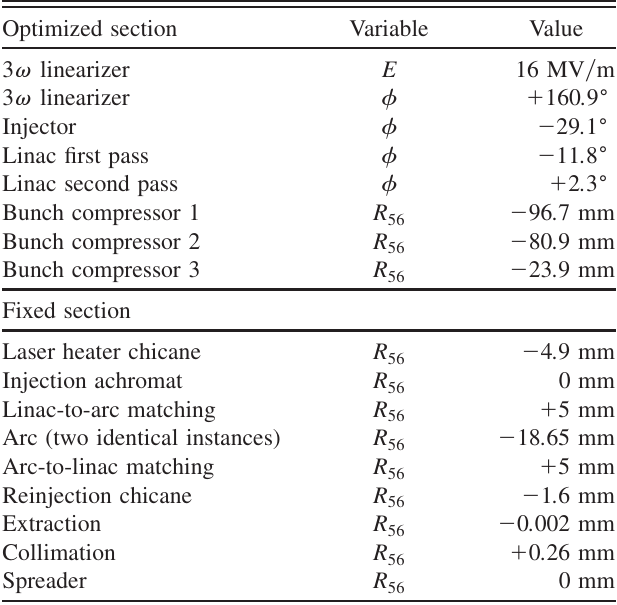
TABLE I. Optimized machine parameters. Phases are with respect to